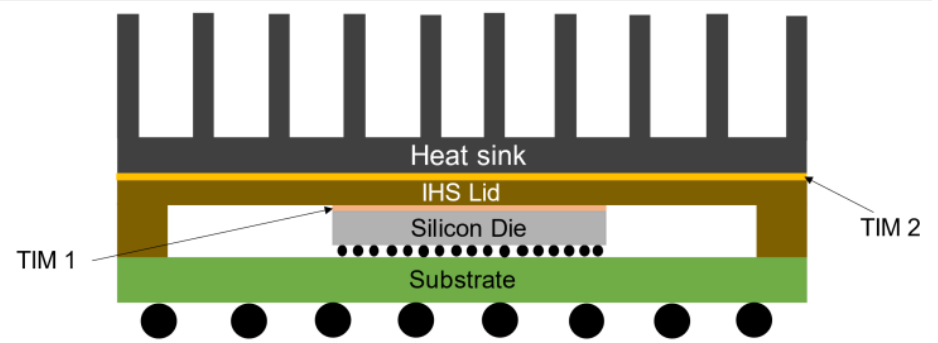
Figure 1. Schematic of electronic package with heat sink and IHS.